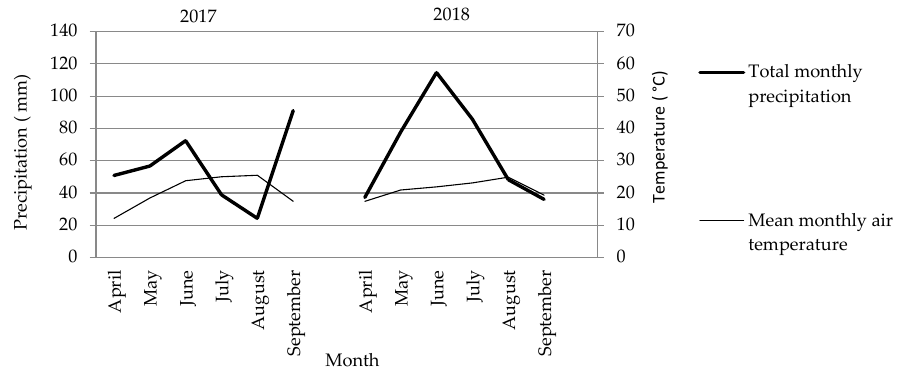
Figure 1. Climate diagram by Walter and Lieth [17] across study periods.